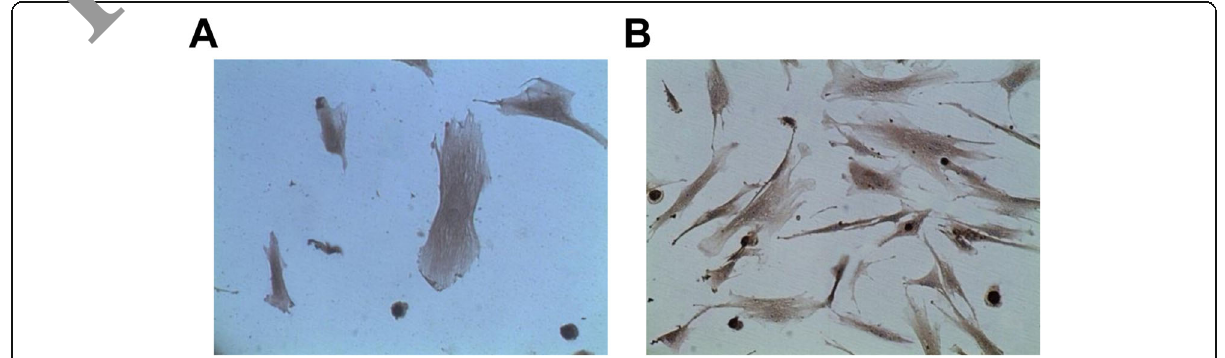
Fig. 3 Vascular ECs react positively to FVIII and CD31 related antigen antibodies. a Identification of ECs by CD31. b Identification of ECs by